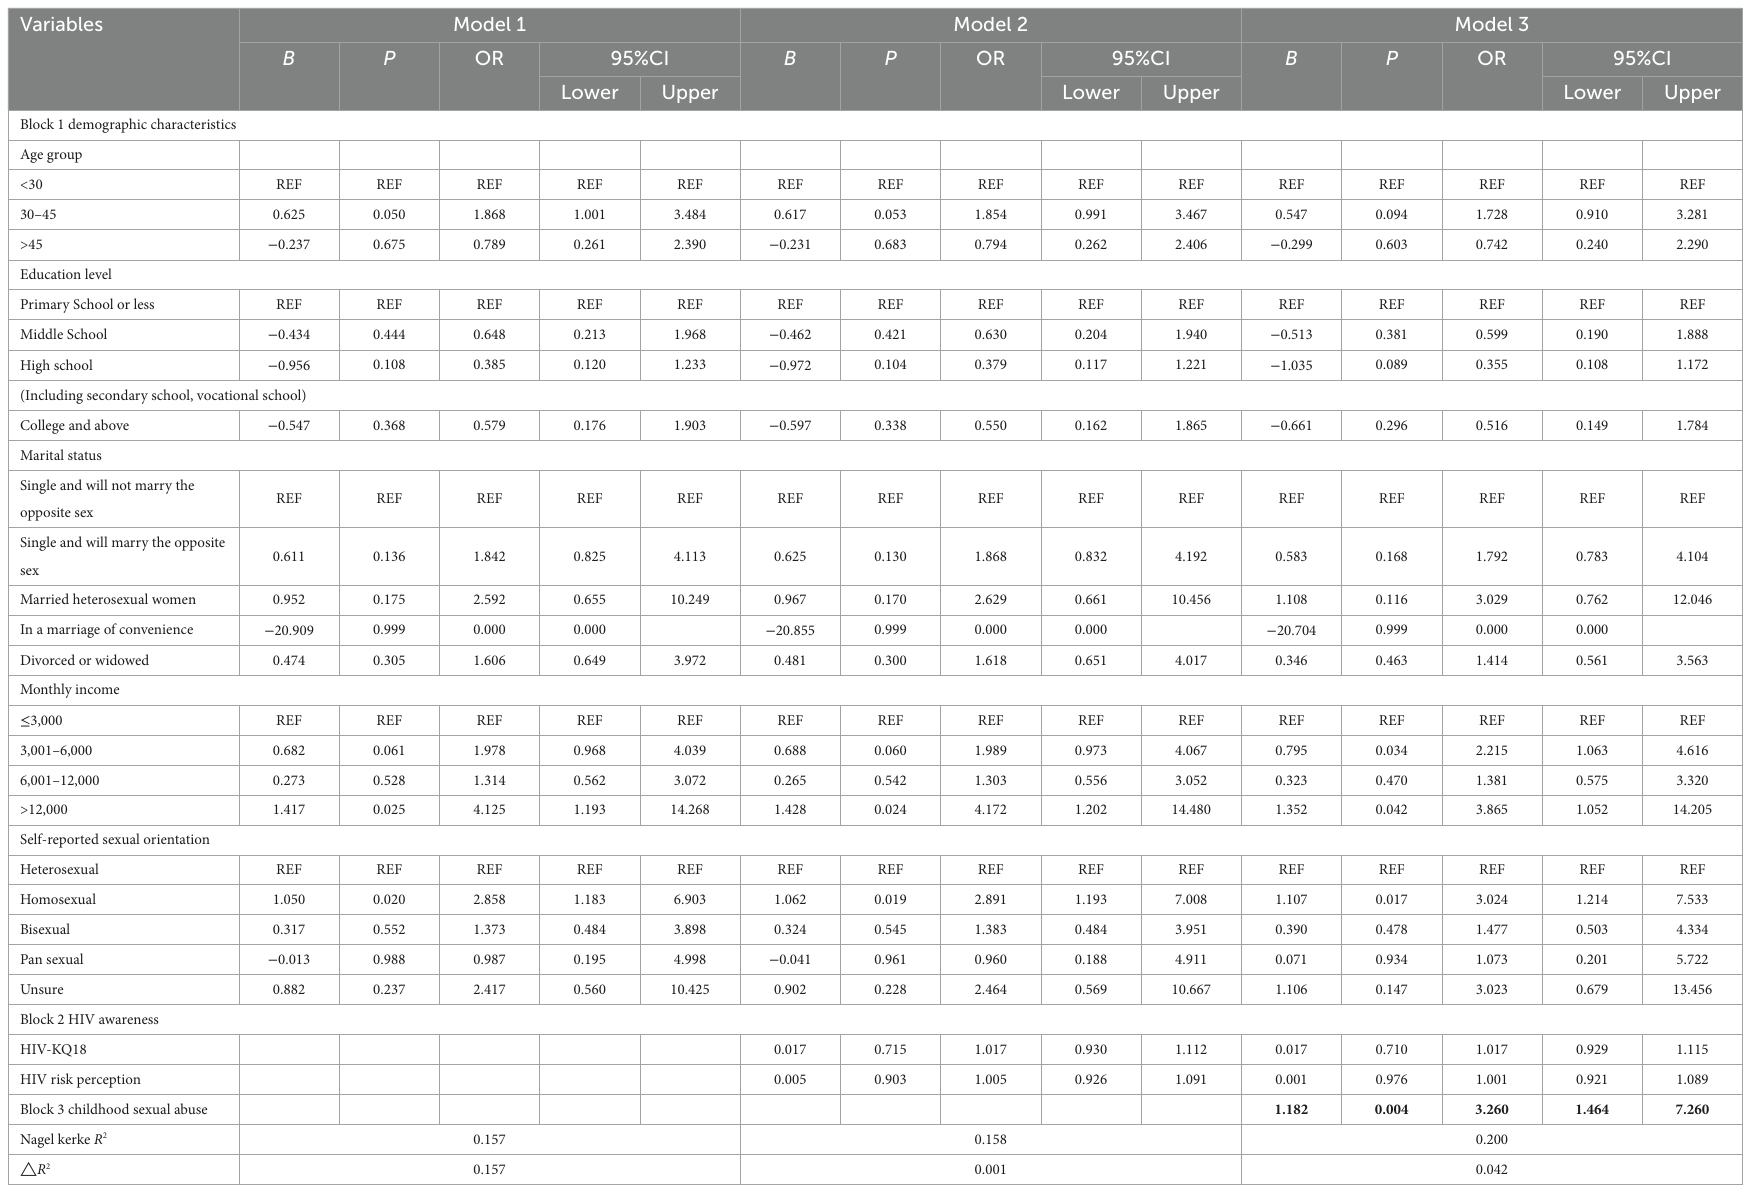
TABLE 3 Hierarchical logistic regression models of multiple sexual